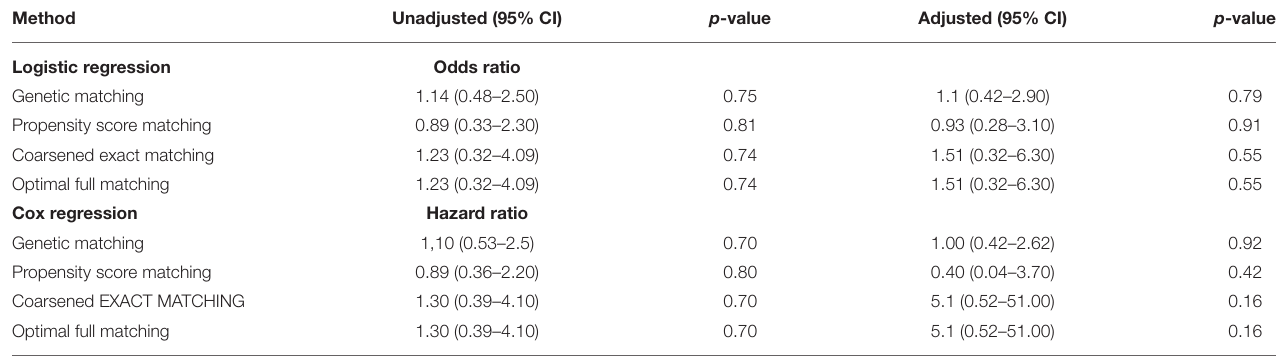
TABLE 2 | Primary outcome (28-day mortality) analysis with four different match